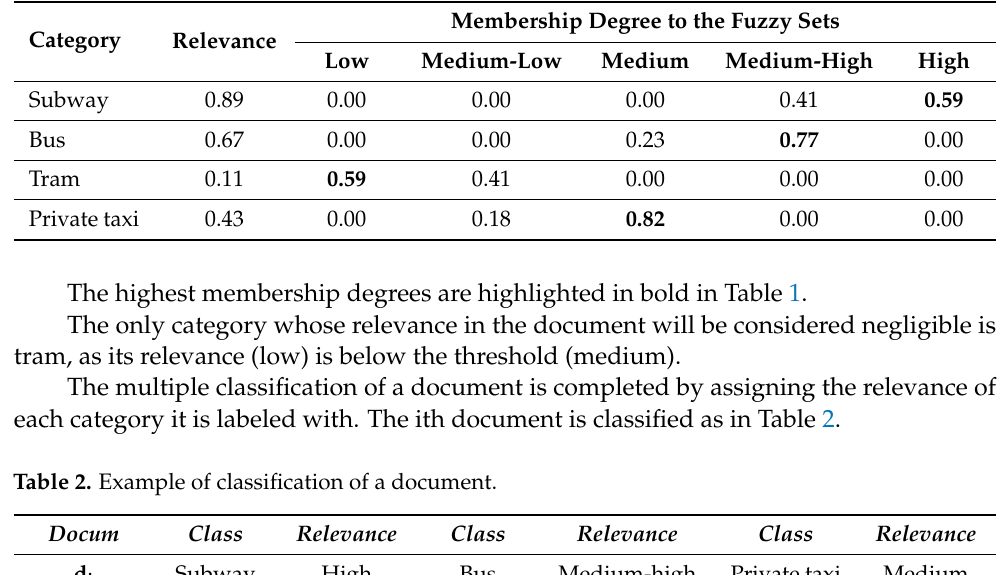
Figure 2. Example of category relevance fuzzy partition composed by five fuzzy sets. Table 1. Example of classification of documents: relevance of the categories in a document.